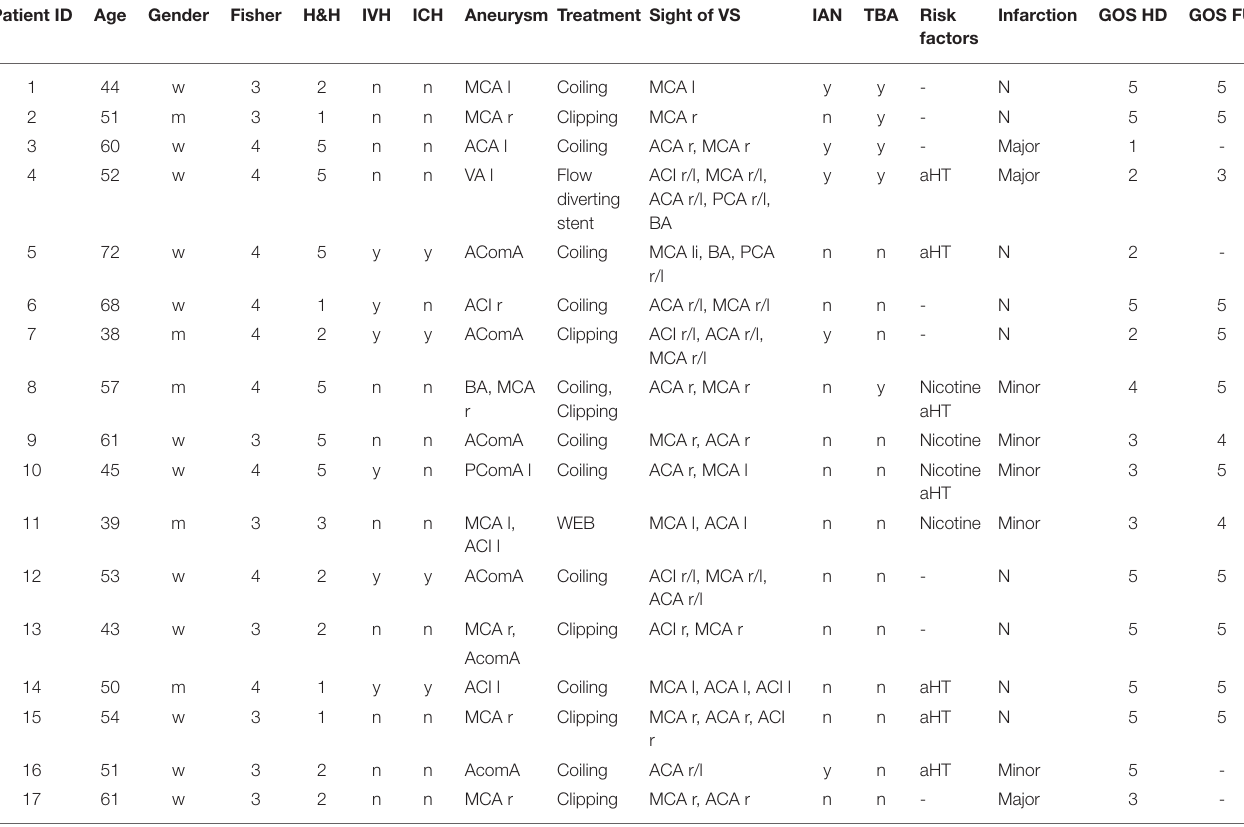
TABLE 1 | Demographic data, SAH classification and risk factors, and outcome of CIAN